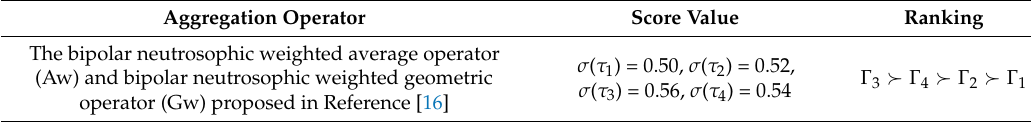
Table 4. Decision results based on four aggregation